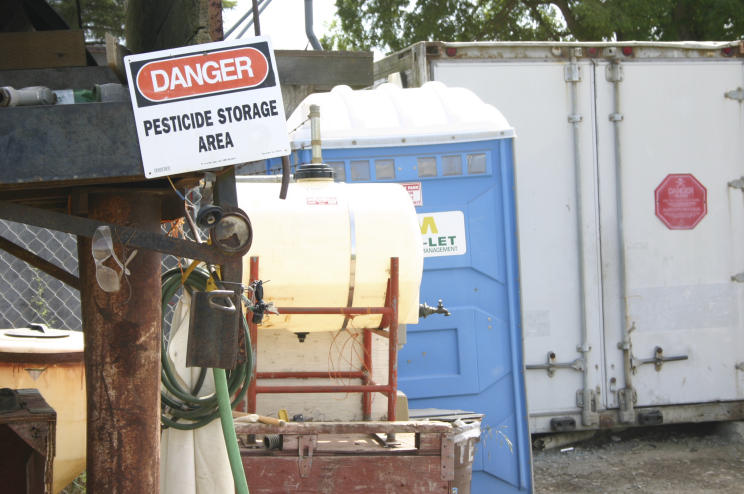
Pesticide Containers Surround Hand-Washing Station and OuthouseContainers of pesticides surround one of the hand-washing stations and outhouses on the farm.